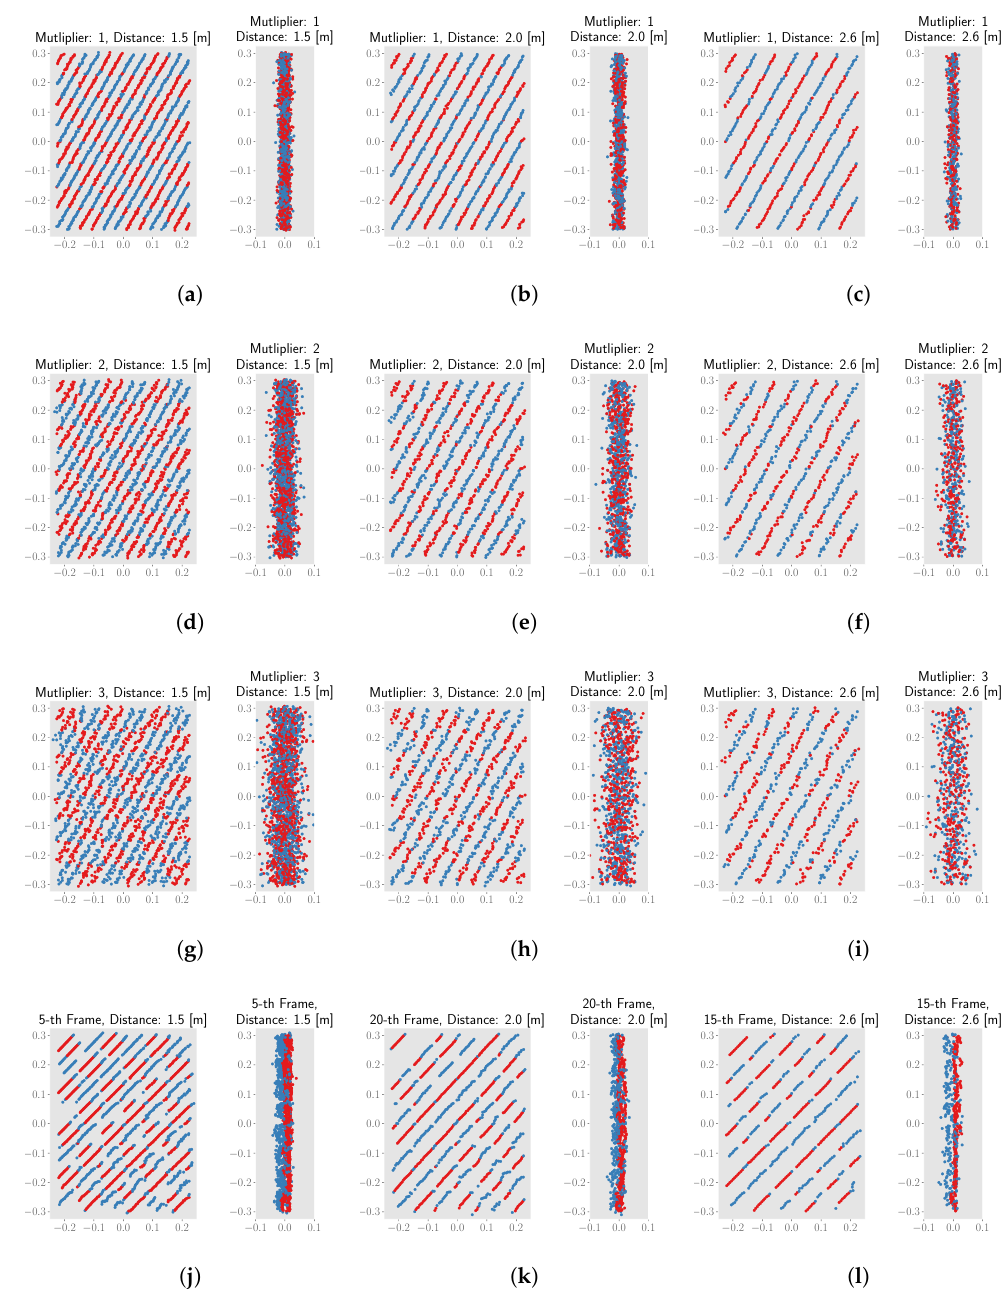
Figure 12. Front view and side view of chessboard’s point clouds from simulation results and real data. ( a – c ) Simulated point clouds with the multiplier 1 at different distances; ( d – f ) Simulated point clouds with the multiplier 2 at different distances; ( g – i ) Simulated point clouds with the multiplier 3 at different distances; ( j – l ) Real point clouds at different